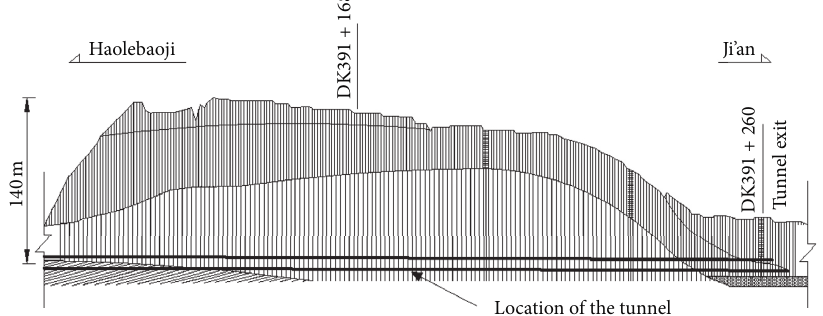
Figure 7: Typical geological section of the tunnel.